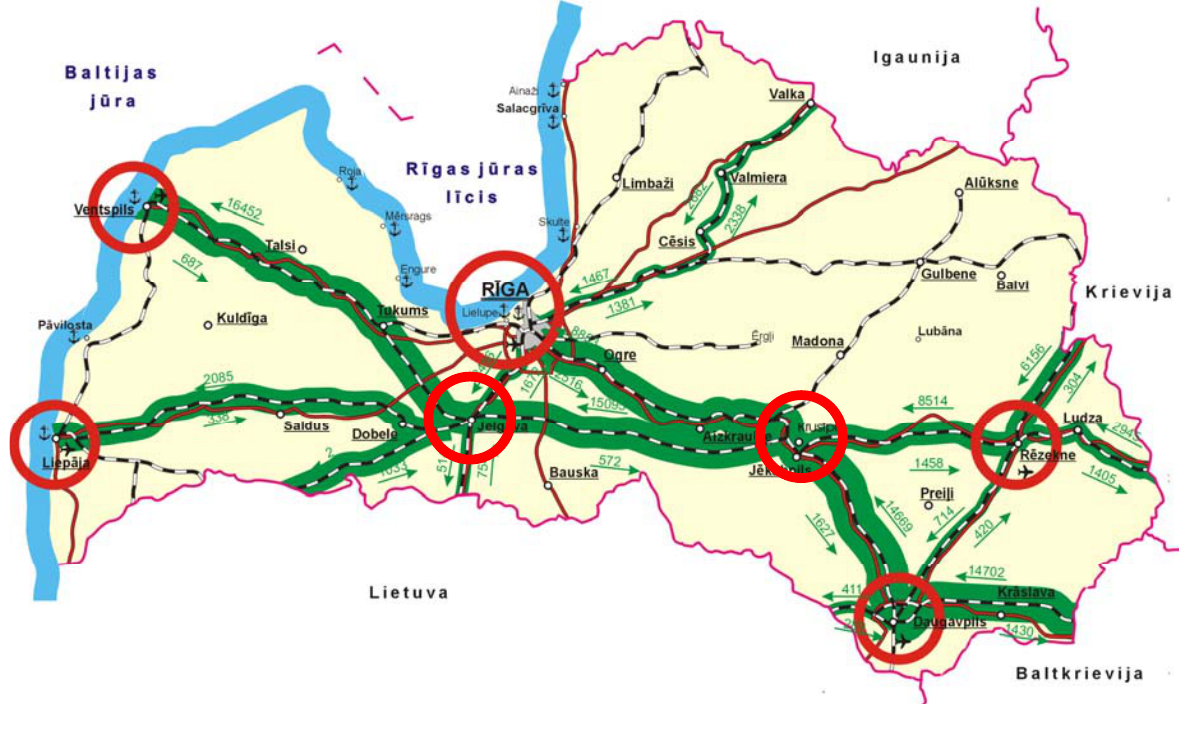
Fig. 1. Network of possible LCs in